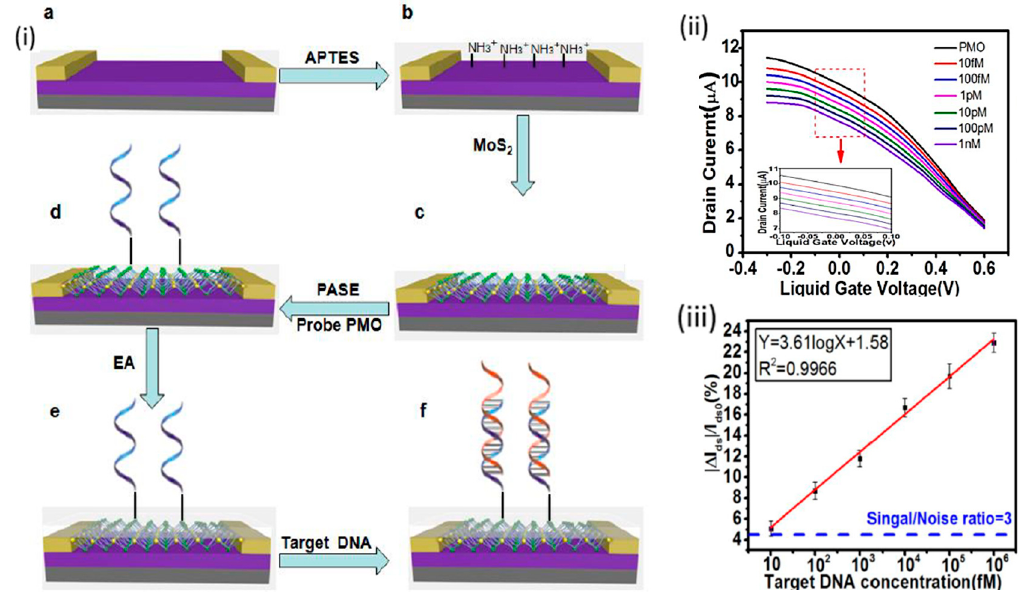
Figure 2. ( i ) A Schematic of the preparation of the MoS 2 FET biosensor for the detection of DNA; SiO 2 /Si substrate with metal contacts ( a ), APTES functionalization of the substrate ( b ), MoS 2 loading ( c ), functionalization of PMO on MoS 2 surface using PASE linker ( d ) exposed surface passivation/blocking using EA ( e ), and target DNA capturing using the sensor ( f ). ( ii ) FET transfer characteristics of the complementary DNA-hybridized phosphorodiamidate morpholino oligos (PMO)-functionalized MoS 2 FET device, at a series of concentrations. ( iii ) Calibration/working curve of the MoS 2 FET at different concentrations of DNA. Reprinted from ref [83], Copyright (2018), with permission from Elsevier.